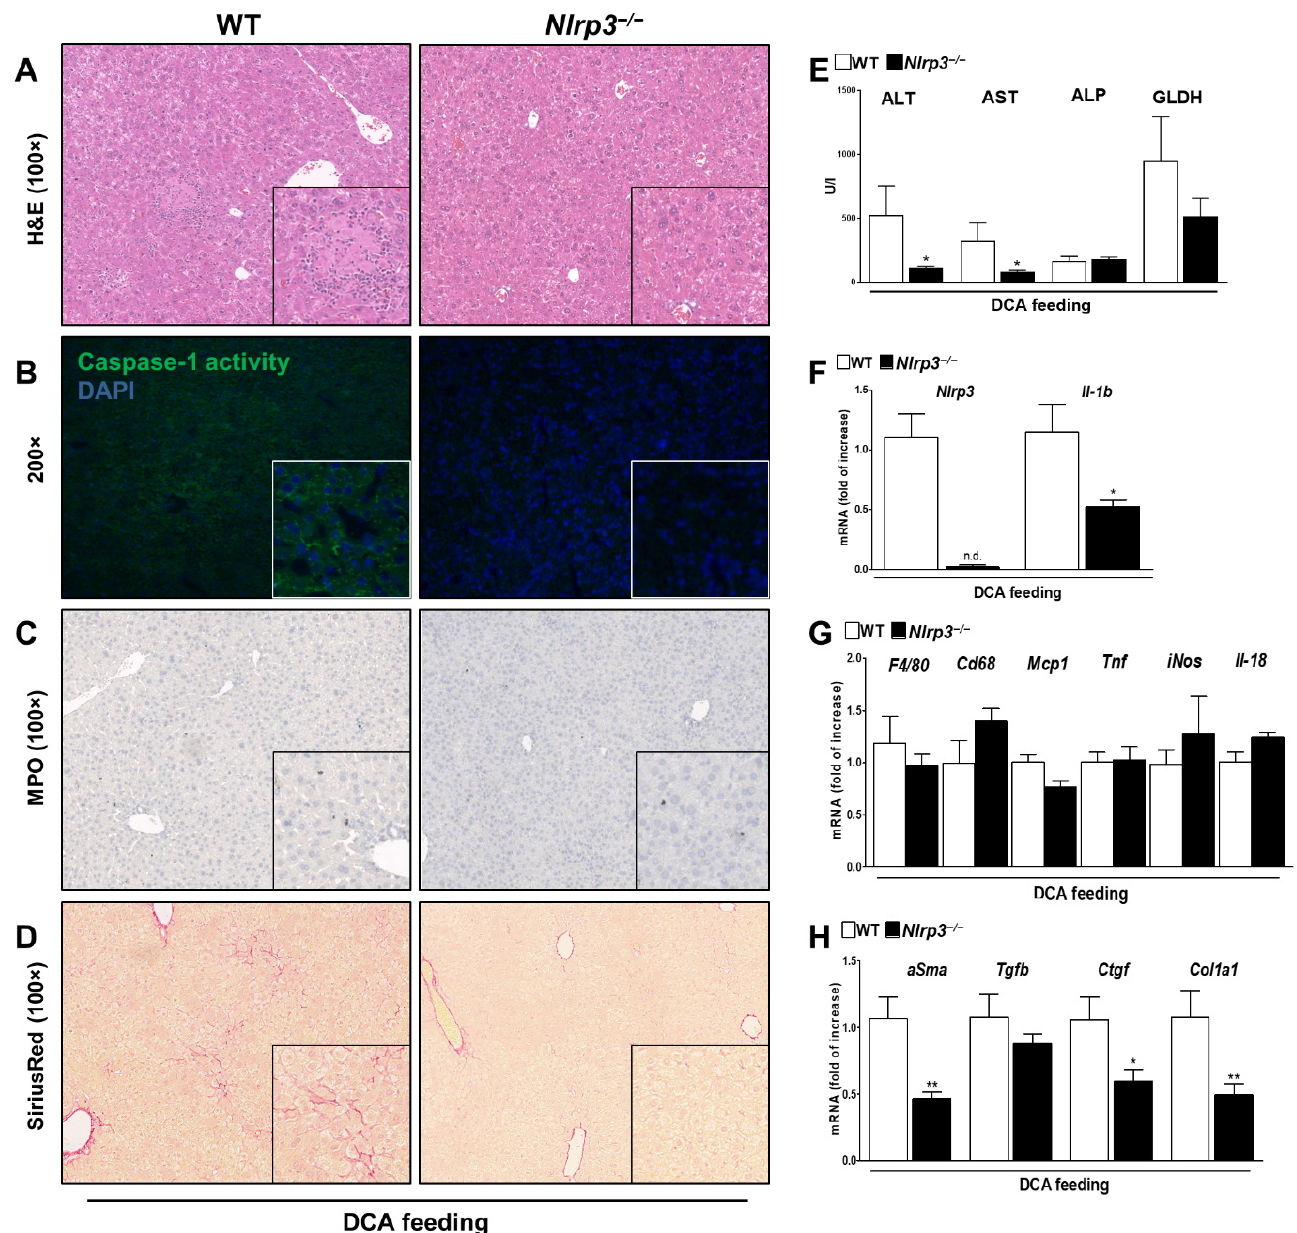
Figure 2. Nlrp3 − / − mice developed less liver damage and fibrosis after DCA feeding. Intermediate liver damage after DCA feeding was ameliorated in Nlrp3 − / − mice as indicated by H&E staining ( A ) and lower transaminase levels ( E ). Nlrp3 − / − mice show reduced Caspase-1 activity and Il-1b mRNA levels ( B , F ), resulting in attenuated fibrotic alterations as shown in SiriusRed stained liver sections ( D ) and decreased mRNA levels of fibrotic markers ( α Sma, Ctgf, Col1a1 ) ( H ). Nlrp3 − / − did not affect MPO positive cells and mRNA levels of F4/80, Cd68, Mcp1, Tnf, iNOS and IL-18 as markers of immune cells invasion ( C , G ). * p < 0.05; ** p < 0.01; n.d.: not detected; n = 6.